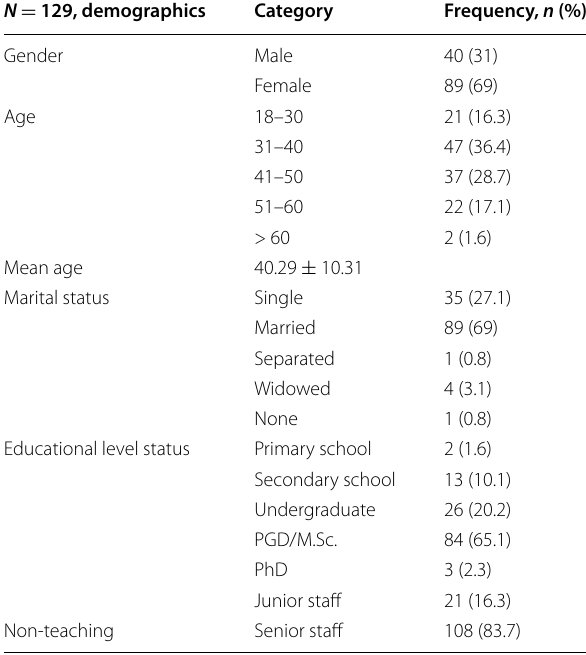
Table 1 Socio-demographics characteristics of the